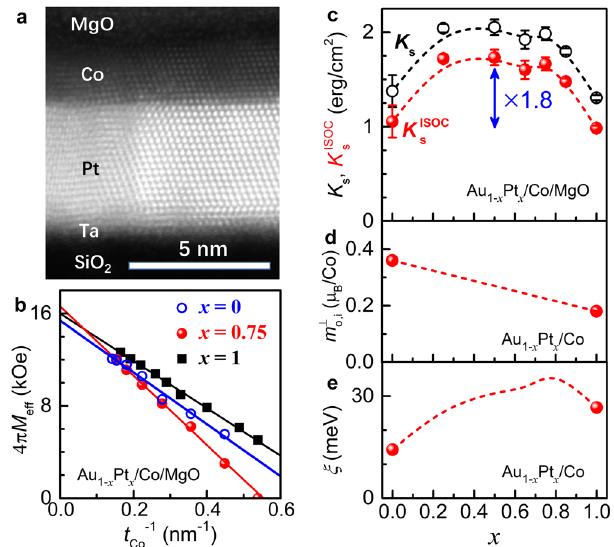
Fig. 1 Interfacial spin-orbit coupling. a Cross-sectional dark- fi eld scanning transmission electron microscopy imaging of a typical Pt/Co/MgO sample (the Co layer is 2.5 nm, the heavy Pt atoms appear to be brighter than the light Co atoms), indicating reasonably sharp Pt/Co and Co/MgO interfaces and negligible interfacial alloying within the measurement resolution. b The inverse thickness ( t Co − 1 ) dependence of the effective demagnetization fi eld 4 π M eff ( x = 1, 0.75, and 0.65) of the Au 1 − x Pt x /Co bilayers. The error bars determined from the standard deviation of the fi t parameters are smaller than the points. The solid lines present the best linear fi ts. c Interfacial magnetic anisotropy energy density for the Au 1 − x Pt x /Co interface ( K ISOC ) s and for the two interfaces of Au 1 − x Pt x /Co/MgO ( K s ) plotted as a function of x . The arrow indicates a factor of 1.8 variation of K ISOC . The error bars s represent the standard deviation of the fi t parameters. The dashed lines in ( c ) are to guide the eyes. d The perpendicular orbital momentum for the single ferromagnetic interface layer ( m ? ) as determined from x-ray o ; i magnetic circular dichroism experiments 22,23,28 and e The strength of interfacial spin-orbit coupling ( ξ ) for the Au 1 − x Pt x /Co interface as determined using the K ISOC in ( c ) following Eq. (2). In ( d ) and ( e ), the solid s points show the experimental data and the dashed lines represent the simple case that m ? of the Au 1 − x Pt x /Co interfaces varies linearly with the o ; i composition of the Au 1 − x Pt x